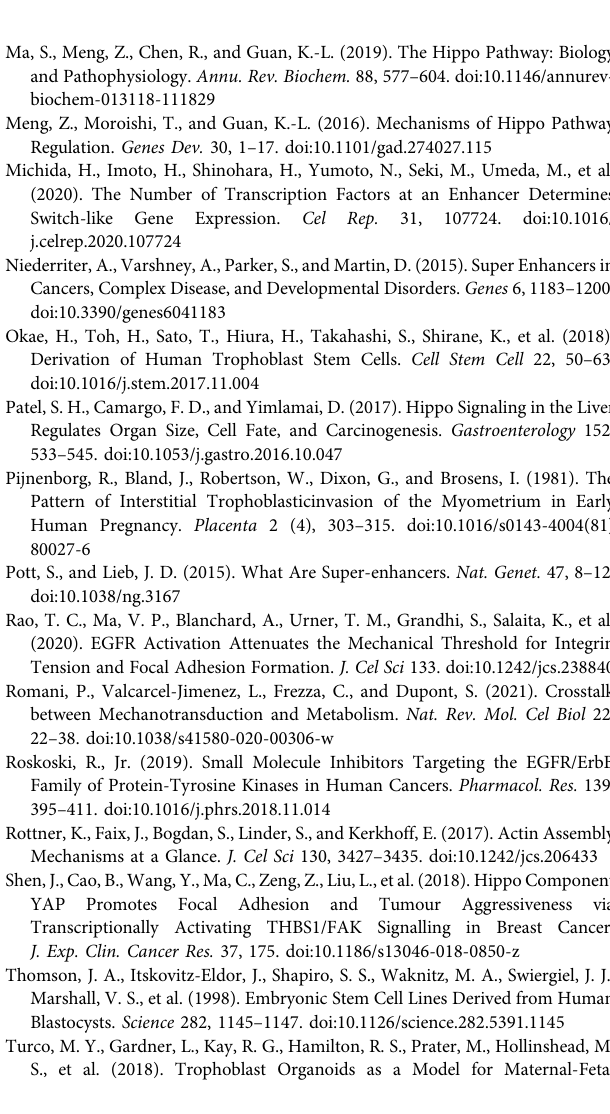
Supplementary Figure S1 | Evaluation of the chromatin accessibility of key cell identity genes. (A) H3K27ac and H3K4me1 signals of TSCs and ATAC-seq